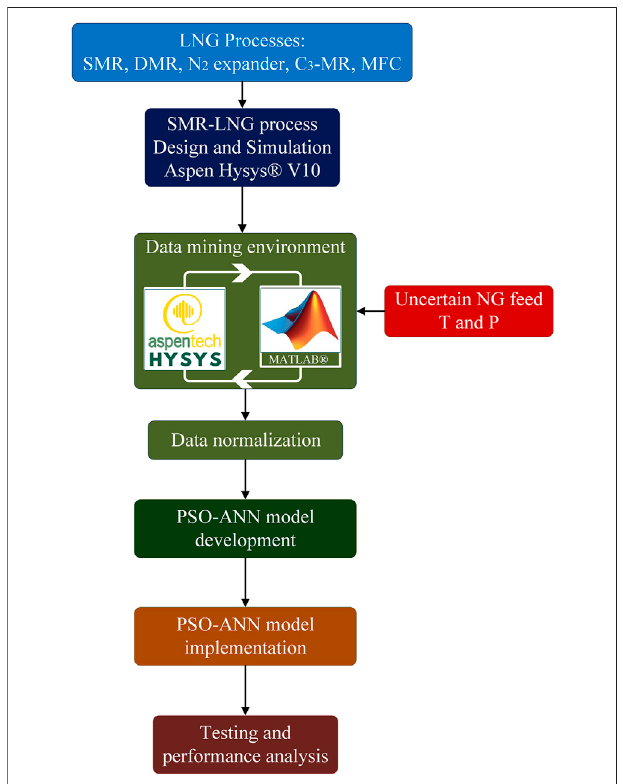
FIGURE 2 | Research methodology of the proposed